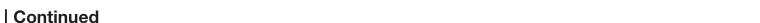
FIGURE 5 | Continued each gene network module grouped by topology. The most overrepresented GO term (biological process) and TF in each module are indicated. (B) Network analysis of genes with significant N/B ANOVA model in which genes also present in the B ANOVA model are highlighted. Yellow nodes indicate genes that also respond to the infection alone, irrespective of the N concentration. X and Y axes do not represent any particular scale. (C) Subnetwork of TFs and their putative targets derived from most co-expressed genes. Arrowhead green lines indicate predicted transcriptional activation, while red lines indicate transcriptional repression. Nodes are color-coded based on biological processes: metabolism (gray), unknown processes (white), defense, and stress response (yellow), response to hormone (purple), JA/ET processes (light blue), oxidative-reduction processes (green), and transport (orange).